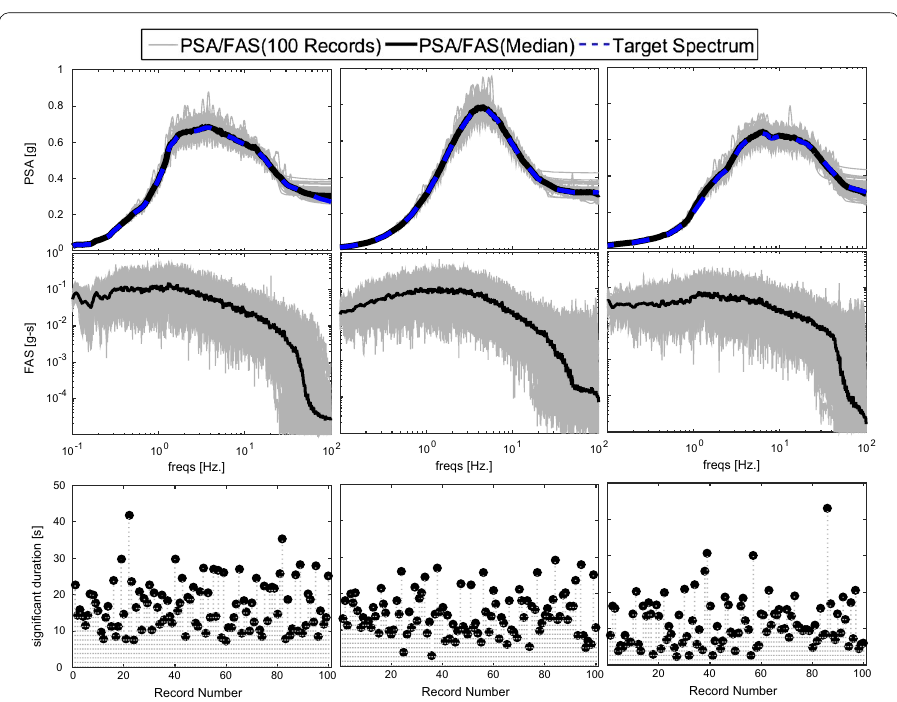
Fig. 2 Top to bottom: pseudo‑acceleration response spectra, Fourier amplitude spectrum, and significant duration (D 5–75 ). Left to right: results corresponding to the NRC, NGA and NUC target